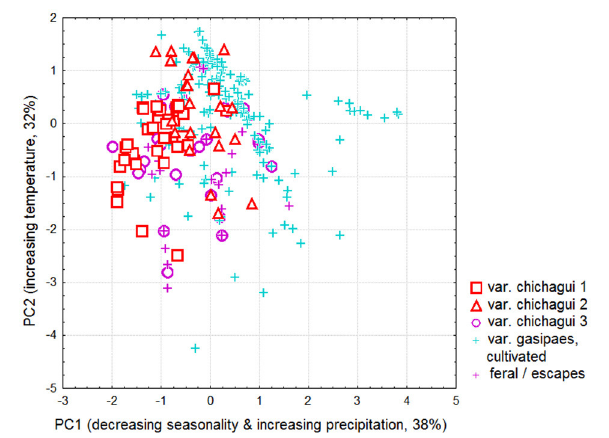
FIGURE 3 | Principal component analysis of bioclimatic parameters for Bactris gasipaes . Projection of observations of var. chichagui types 1, 2, and 3, cultivated var. gasipaes , and feral or escaped specimens found in disturbed or secondary vegetation in the principal plane. Axis legends identify the main relations of principal components with original variables and percentage of explained